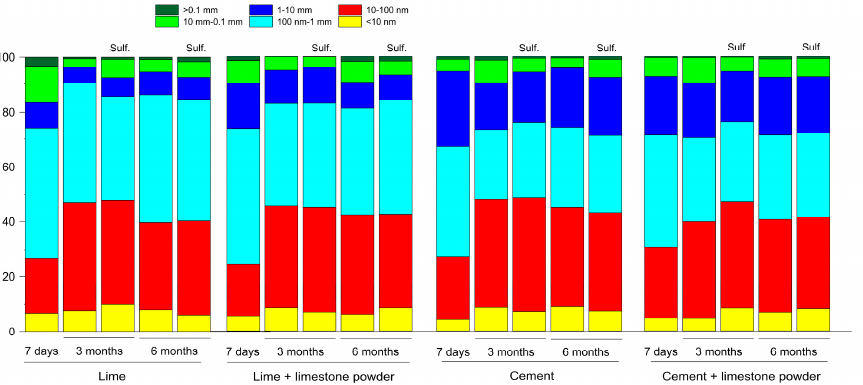
Figure 5. Intrusion volume for lime and cement samples with and without the industrial waste at 7 days and at 3 and 6 months.